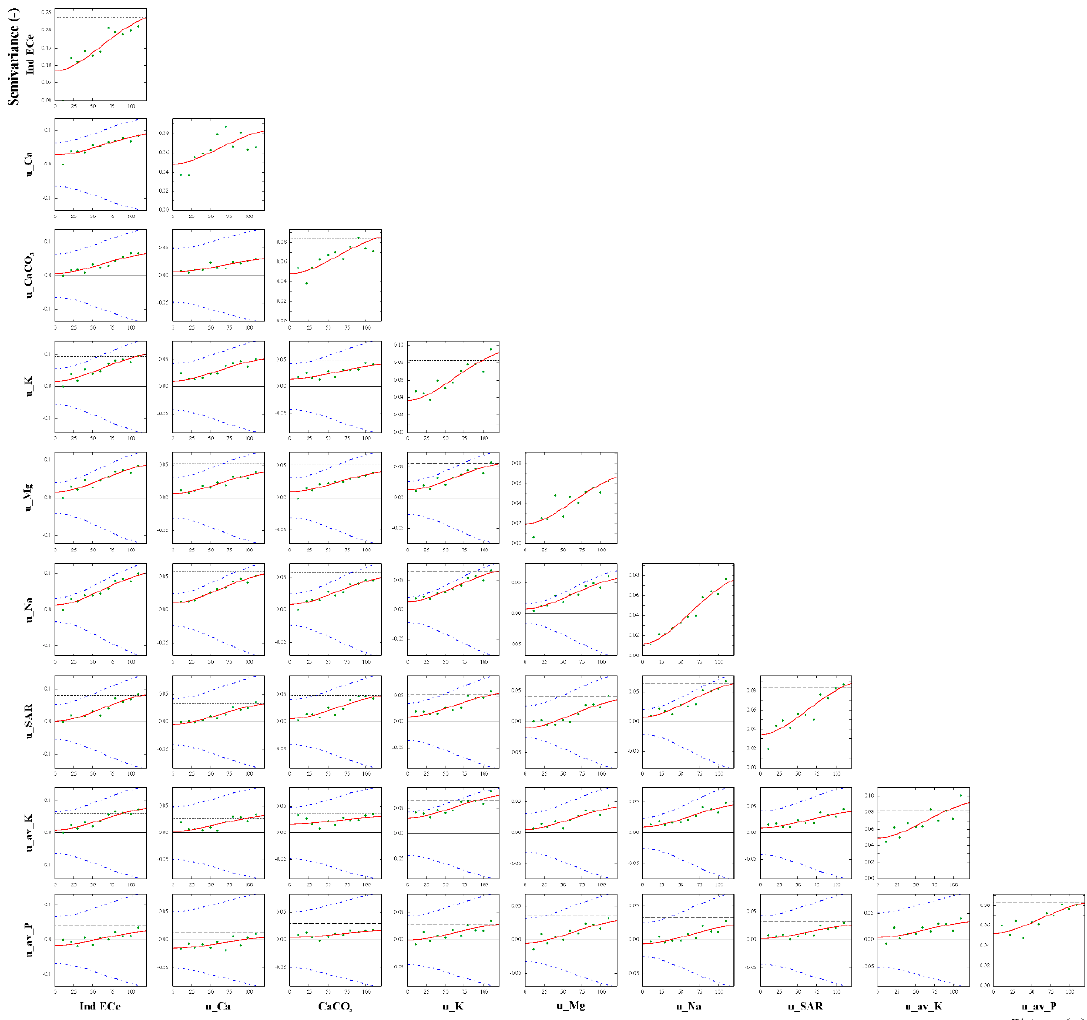
Figure 2. Direct and cross-semivariograms between the indicator transformation of ECe (I_ECe) and the uniform transformed variables. The experimental values are the plotted green points and the red solid lines represent the model of co-regionalization. The blue dash-dotted lines are the hull of perfect correlation [37] and the black dashed lines are the experimental variances.